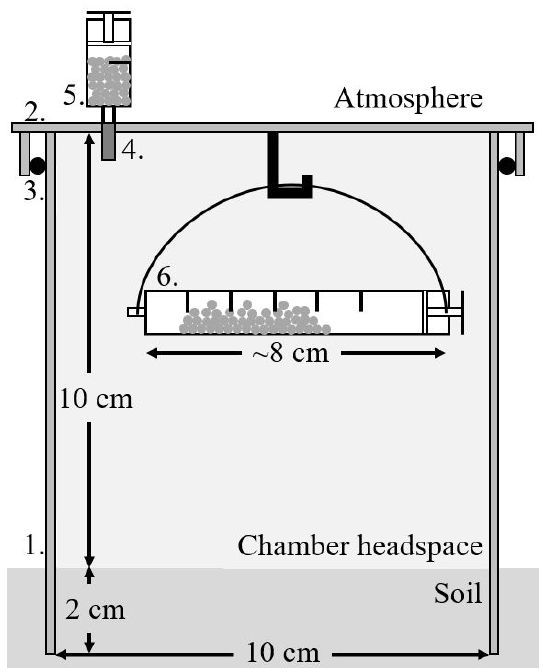
Figure 1. Sketch of the soda-lime method with an open and static chamber (after Apostolakis et al. [33]). A PVC ring (1) of 12 cm is inserted to the soil down to 2 cm. A PVC lid (2) is placed over the PVC ring and a plastic O-ring (3) ensures the airtightness of the chamber. The color of the PVC ring and lid was orange brown. A plastic tube (4), which is glued on the PVC lid with CO 2 -impermeable silicon, passes through the PVC lid. This tube provides a flow-channel between the headspace of the chamber and ambient atmosphere and, thus, pressure equilibrium between the two. In line with the plastic tube, a syringe (5) with 4 holes of a diameter of 1 mm is placed out of the chamber. This syringe contains soda-lime granules to prevent atmospheric CO 2 from entering the headspace of the chamber. Inside the chamber, a syringe (6) with 64 holes (1 mm diameter) is held from a hook and contains soda-lime granules for the determination of soil CO 2 efflux.